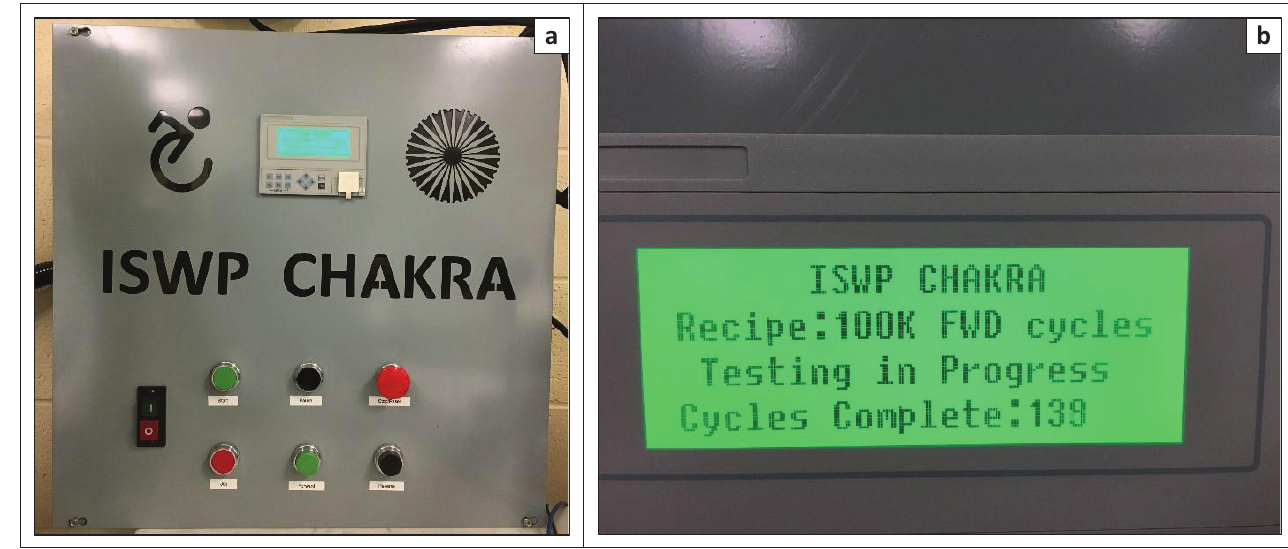
FIGURE 9: Controller box of the caster test system (left) and LCD display (right).